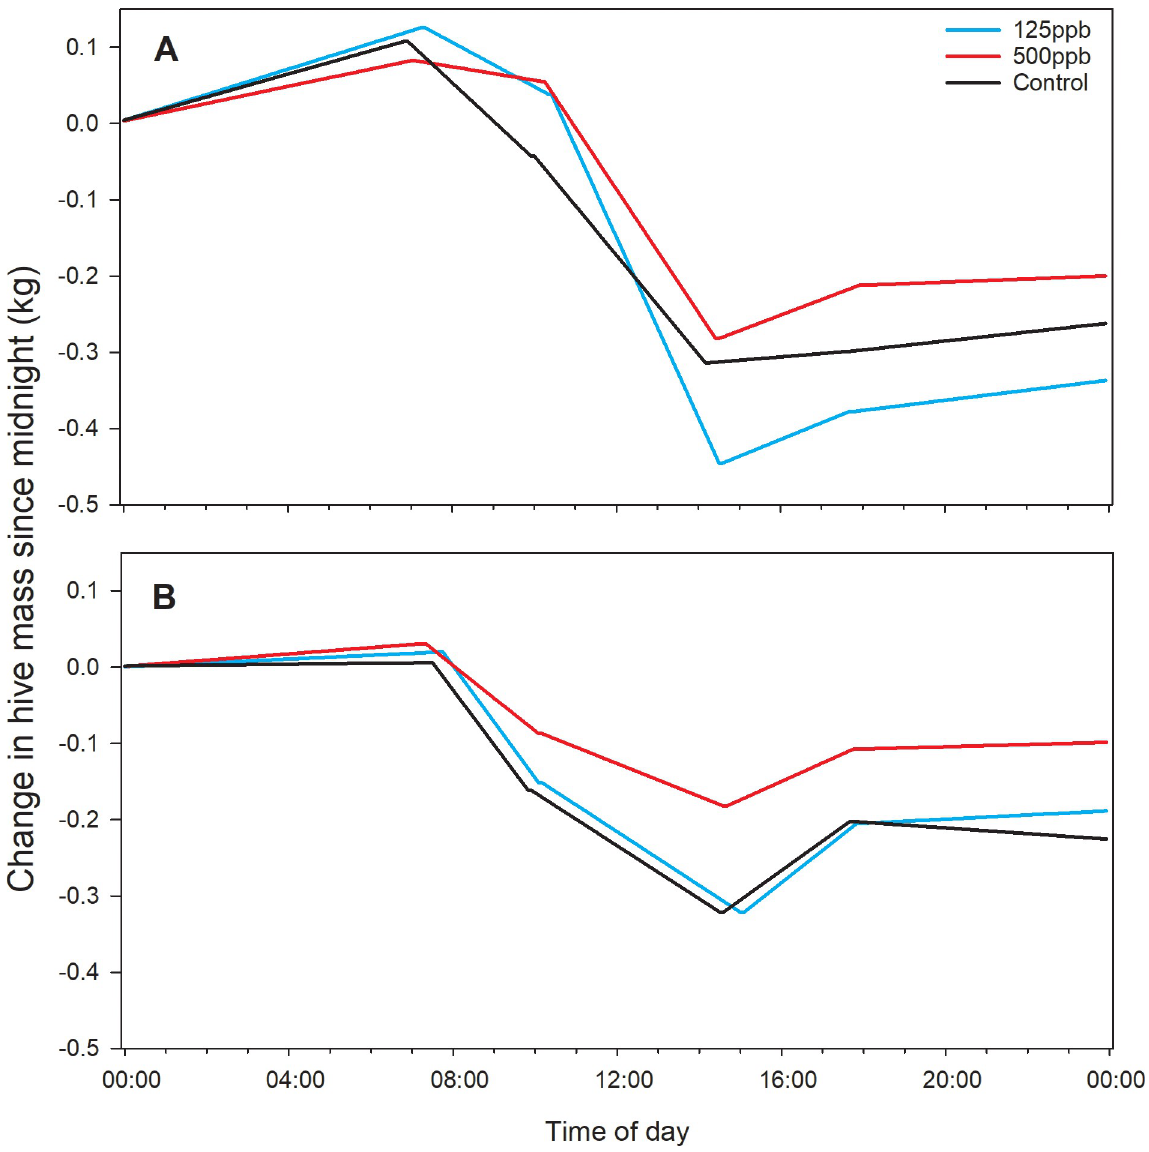
Fig 4. Average within-day weight changes for each treatment group. Curves were estimated using slope and break point values averaged across all colonies within each treatment group and across all days post treatment. (A) Fall 2016 experiment; (B) Fall 2017 experiment. Graphs have the same